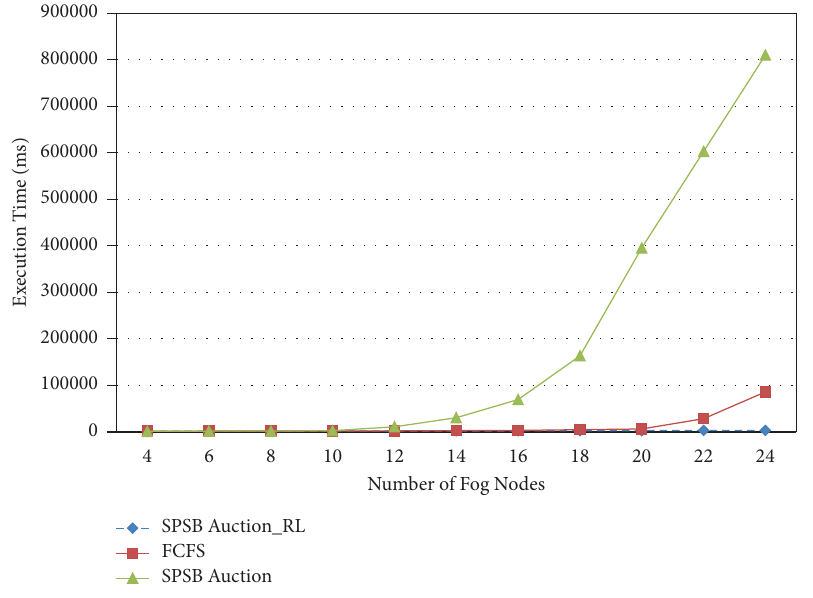
Figure 4: Execution time for diferent numbers of fog nodes. Table 4: Intragroup and intergroup values obtained from the ANOVA test regarding the execution time.